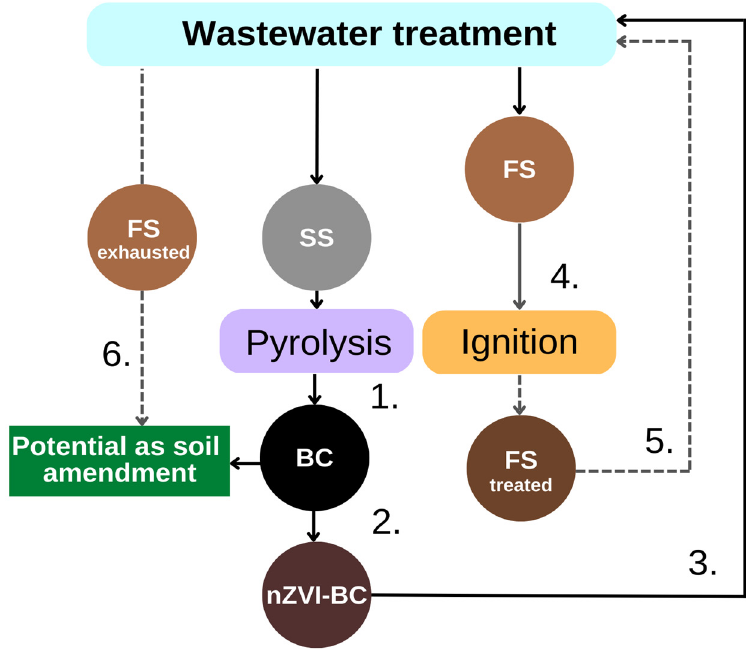
Figure 1. Schematic presentation of the phases of the conducted experiments (1. Pyrolysis, 2. Synthesis of nZVI-BC; 3. nZVI-BC application as Fenton catalyst; 4. ignition of Fenton sludge (FS) to form FS treated ; 5. FS treated application as Fenton catalyst; 6. FS application in nutrient release experiments after ignition).